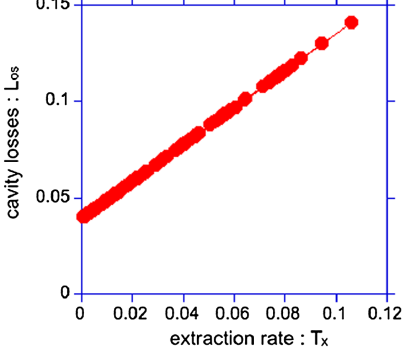
FIG. 5. Total losses L rate T x